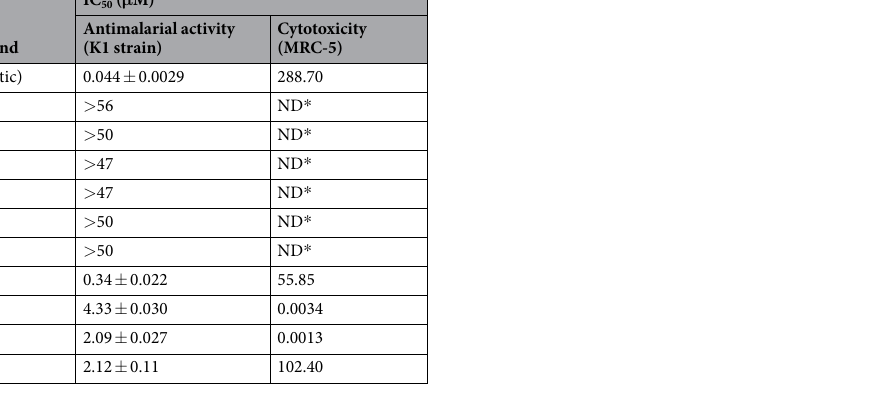
Table 1. In vitro antimalarial activity against Plasmodium falciparum K1 strain and cytotoxicity against MRC-5 cells of total synthetic intermediates, 7-hydroxytropolones and methylated derivatives. * ND: not